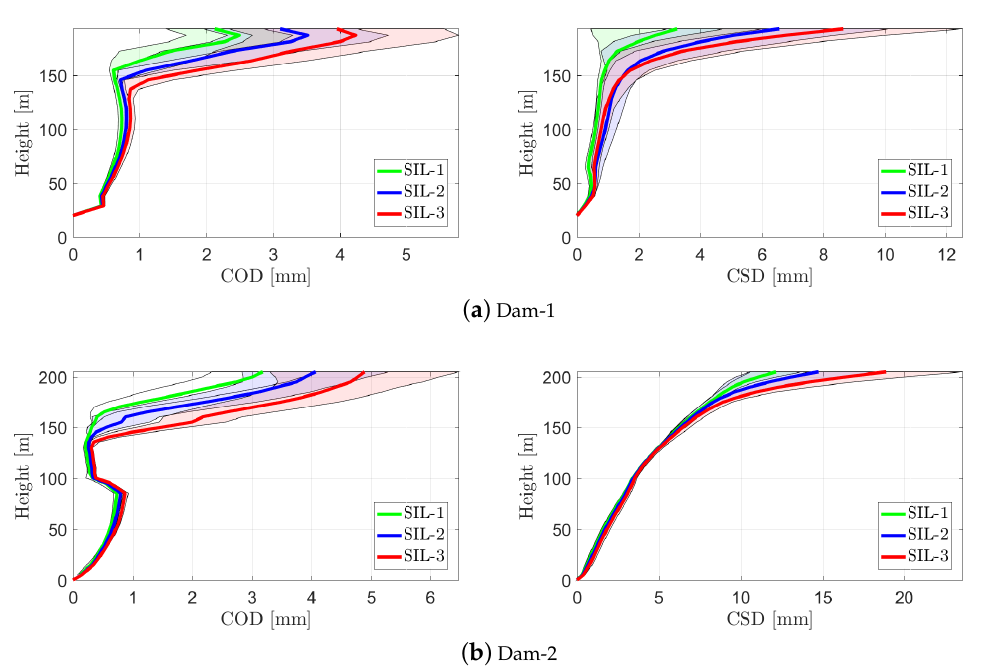
Figure 8. ( a , b ) Joint opening and sliding of arch dams subjected to three seismic intensity